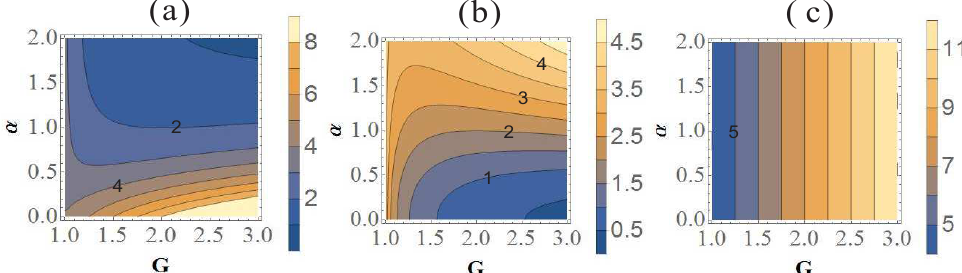
Figure 2. The dependence of D s 1 ( a ), D s 2 ( b ), and D 12 ( c ) on the gain G and interaction strength ratio α